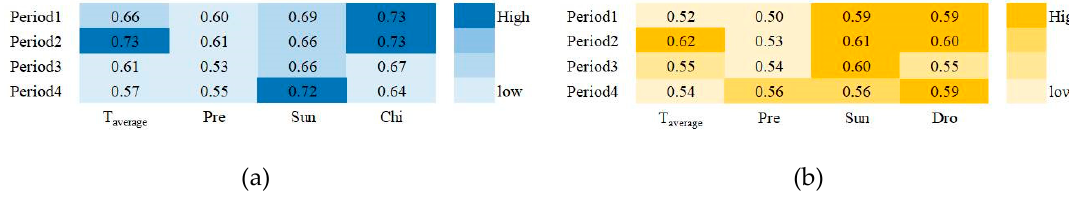
Figure 10. Suitability limitations in the east ( a ) and the west ( b ). T average : average temperature, Pre: precipitation, Sun: sunshine hours, Chi: the chilling injury index, Dro: the water deficit index.